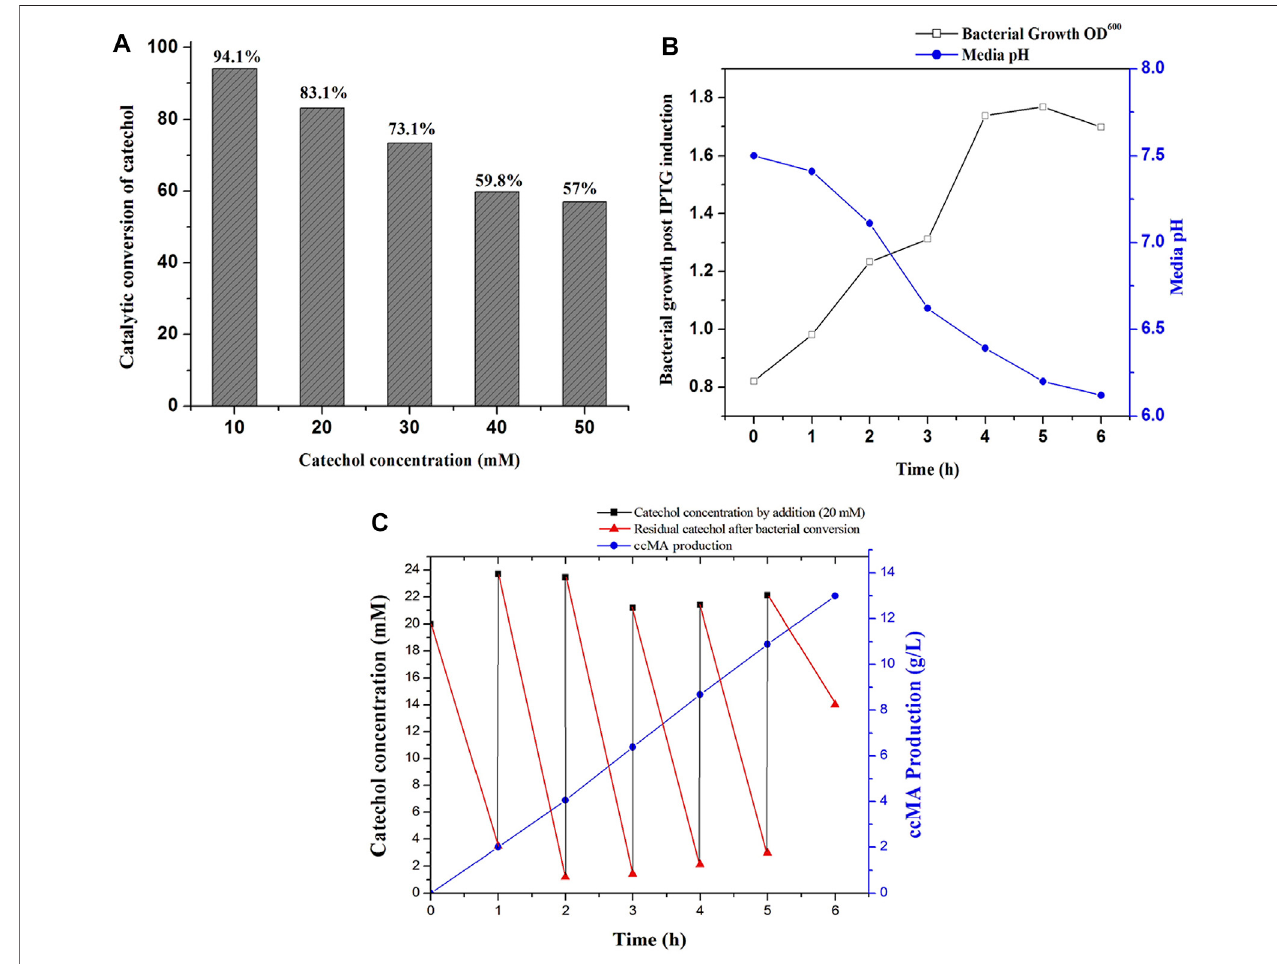
FIGURE4| ccMAproductionbyfed-batchfermentation. (A) Determinationofsubstrateconcentrationforcatalyticconversionbywhole-cellscatalyzedreactionsat 1 h, (B) Bacterial growth pro fi le and media pH during fed-batch fermentation, (C) ccMA production and catechol reduction followed by successive supply of 20 mM catechol at 1 h interval up to 6